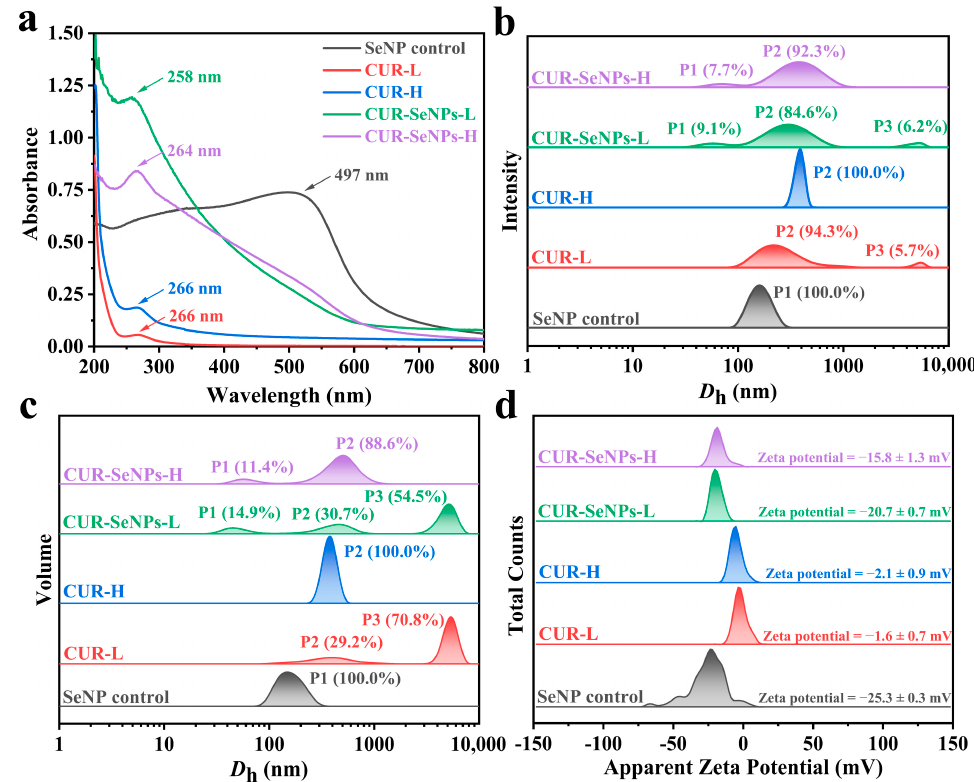
Figure 2. ( a )Theultravioletspectra,( b )hydrodynamic-diameterdistributionbyintensity,( c )hydrodynamic- Figure 2. ( a ) The ultraviolet spectra, ( b ) hydrodynamic-diameter distribution by intensity, ( c ) hy- drodynamic-diameter distribution by volume, and ( d ) zeta potential of CUR-SeNP samples. diameter distribution by volume, and ( d ) zeta potential of CUR-SeNP